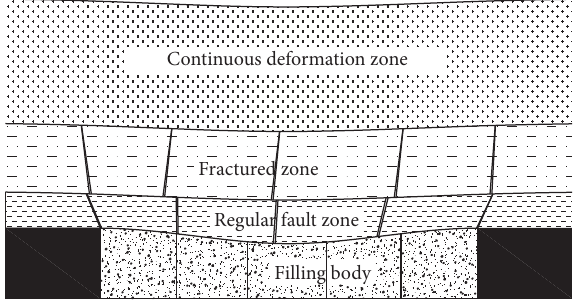
Figure 7: Schematic diagram of the roof regularly caving zone with roadway backfill.